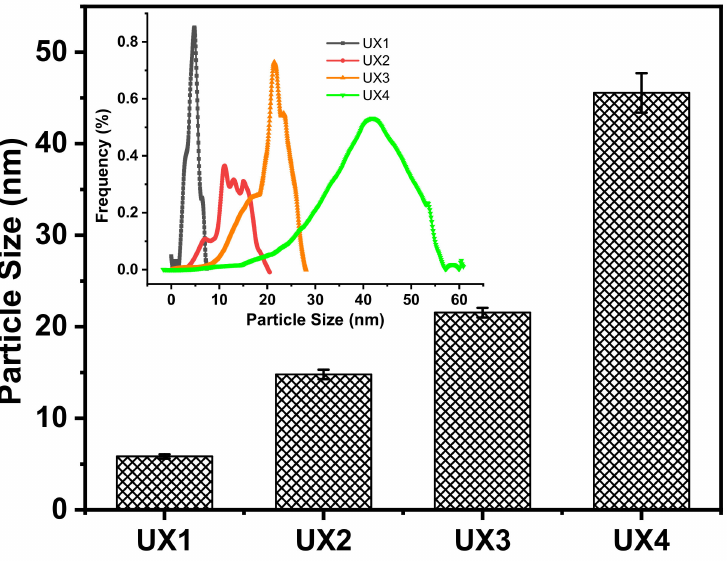
Figure 3. Particle size distribution and the average particle size of xylan colloidal